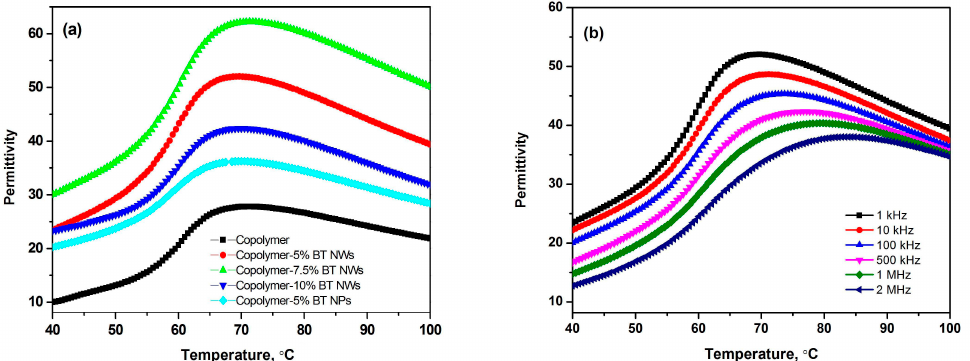
Figure 5. ( a ) The temperature-dependent permittivity of P(VDF–TrFE) copolymer and P(VDF–TrFE)–BT nanocomposites measured at 1 kHz. ( b ) The dielectric relaxation of P(VDF–TrFE)-BTNW nanocomposite containing 5% volume fraction of BT